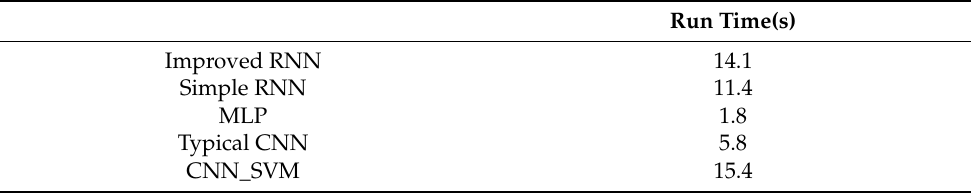
Table 2. Average run time of different